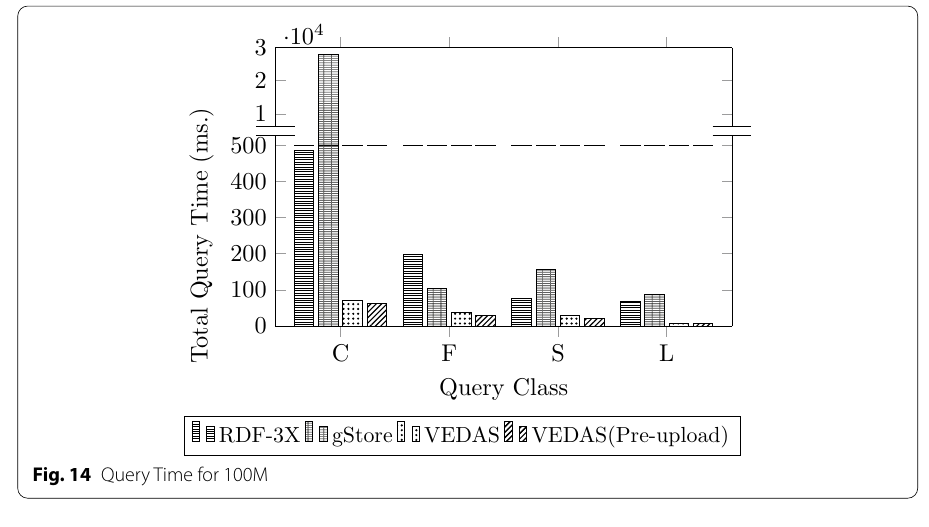
Fig. 14 Query Time for 100M